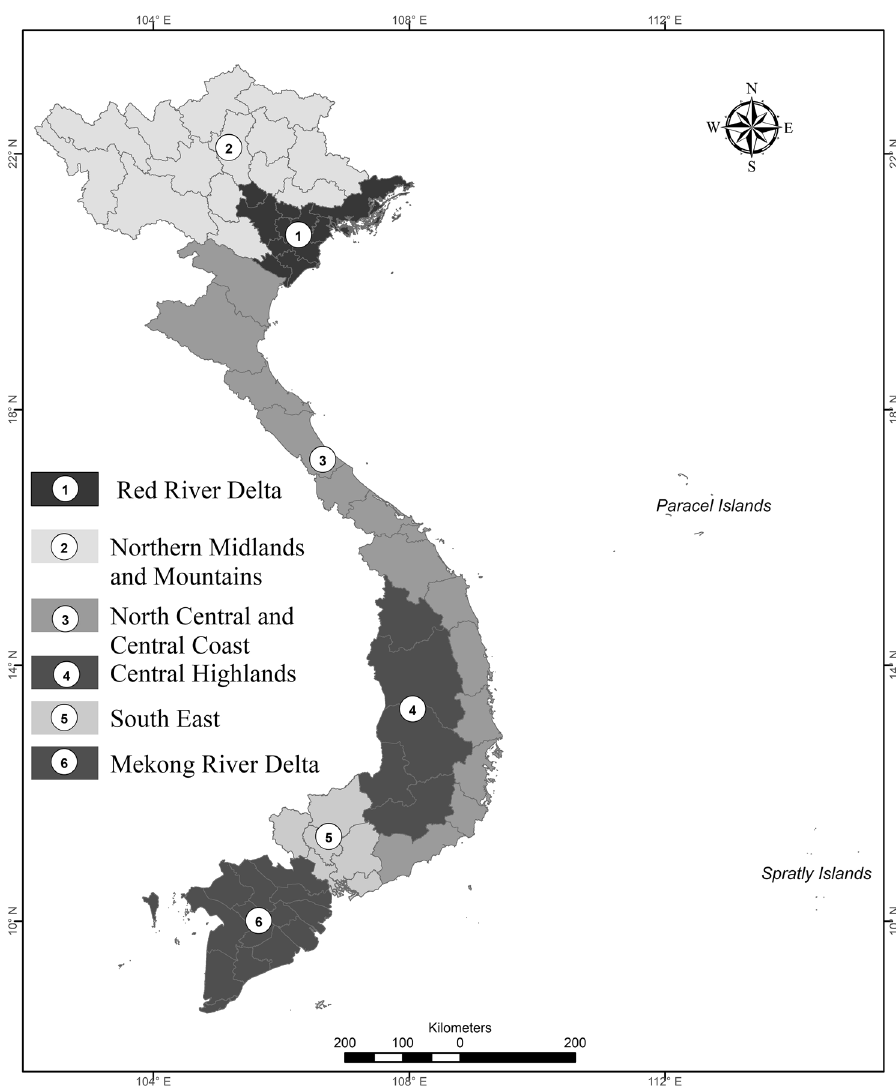
Figure 1. Administrative classification of major socio-economic areas in Vietnam. This map was generated using ArcGIS version 10.2 (https ://deskt op.arcgi s.com/en/arcma